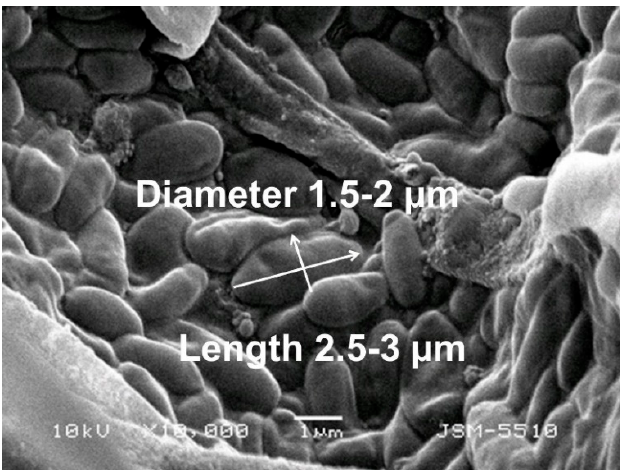
Figure 9. SEM micrograph of the P. chlamydospora conidia.